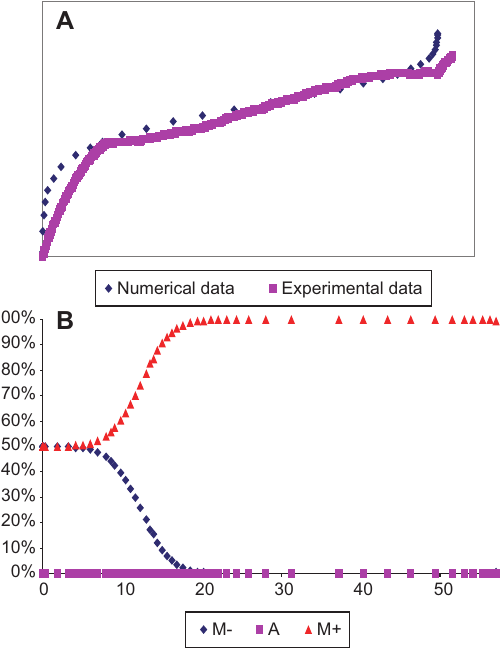
Figure 15 (A) Mechanical load cycle of a NiTi shape memory alloy wire specimen of 3 mm diameter and length 200 mm